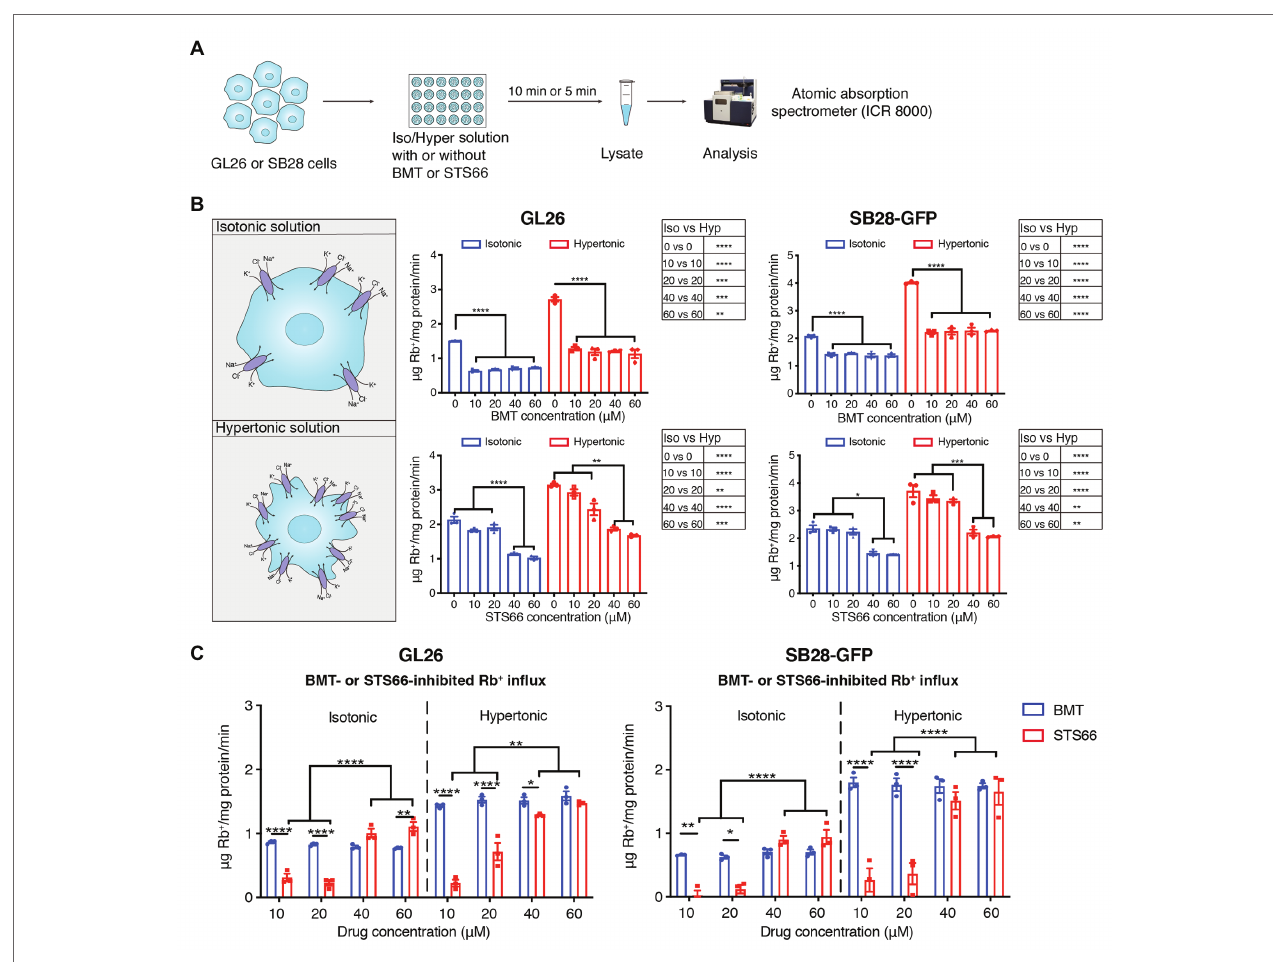
FIGURE 1 | STS66 reduces NKCC1-mediated Rb + influx in cultured glioma cells in a dose-dependent manner. (A) Experimental protocol. (B) Total Rb + influx. GL26 or SB28-GFP cells were exposed to either isotonic (310 mOsm) or hypertonic (400 mOsm) solutions containing different concentrations of bumetanide (BMT; 0, 10, 20, 40, and 60 μ M) or STS66 (0, 10, 20, 40, and 60 μ M). Rb + influx into cells under above conditions was assayed and determined using ICR 8000. (C) BMT- or STS66-inhibited Rb + influx (NKCC1 activity). Data are means ± SEM ( n = 3), * p < 0.05, ** p < 0.01, *** p < 0.001, **** p <